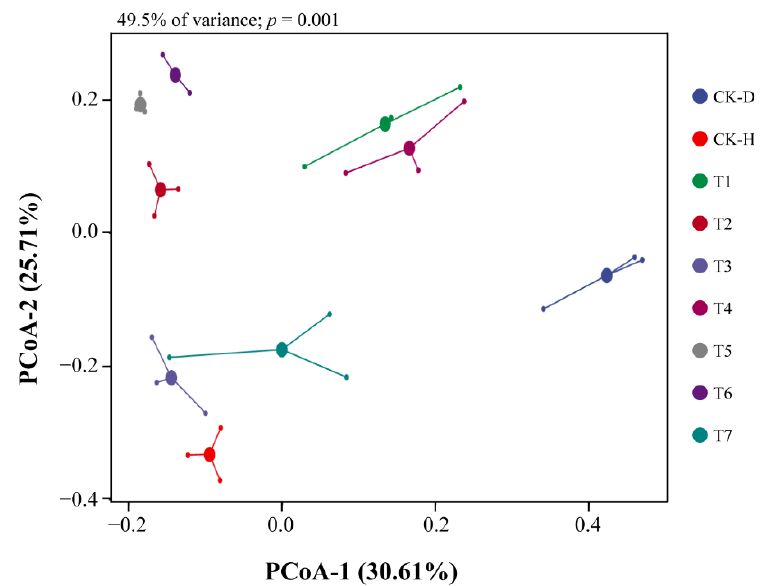
Figure 3. Principal coordinate analysis (PCoA) based on the Bray–Curtis dissimilarity metric showing the beta diversity of bacterial community structure under different treatments (n = 3/treatment). Disease control (CK-D), healthy control (CK-H), single-strain Lysobacter antibioticus 13-6 (T1), single-strain L. capsici ZST1-2 (T2), single-strain Bacillus cereus BT-23 (T3), intra-genus co-culture of L. antibioticus 13-6 + L. capsici ZST1-2 (T4), inter-genus co-culture of L. antibioticus 13-6 + B. cereus BT-23 (T5), micro- bial consortia B. cereus BT-23 + L. antibioticus 13-6 + L. capsici ZST1-2 (T6), and commercial fungicide Kejia